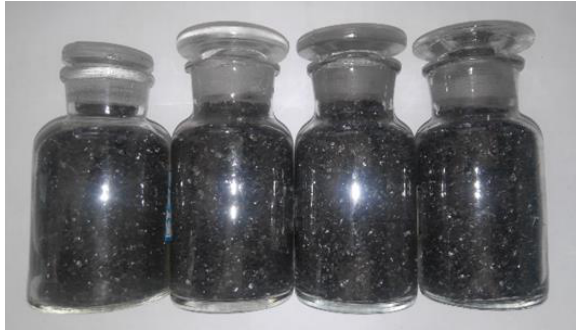
Figure 1. The granular coal sample.